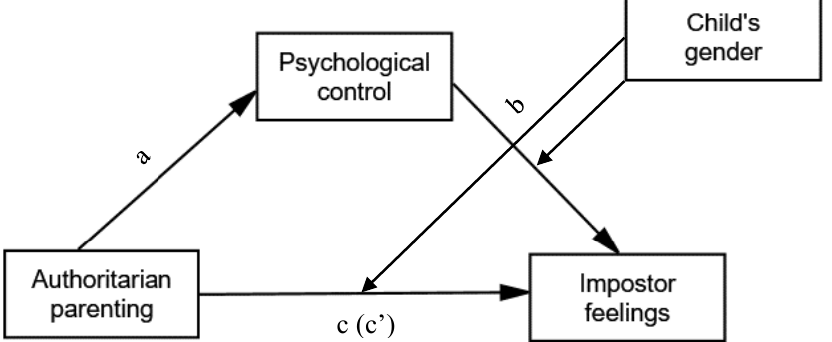
Figure 1. Hypothesized moderation and moderated mediation model for adolescents’ impostor feelings. Direct effect of authoritarian parenting on psychological control (a); direct effect of parental psychological control on adolescents’ impostor feelings (b); total effect of authoritarian parenting on adolescents’ impostor feelings (c); direct effect of authoritarian parenting on adolescents’ impostor feelings, controlling for parental psychological control (c (cid:48)